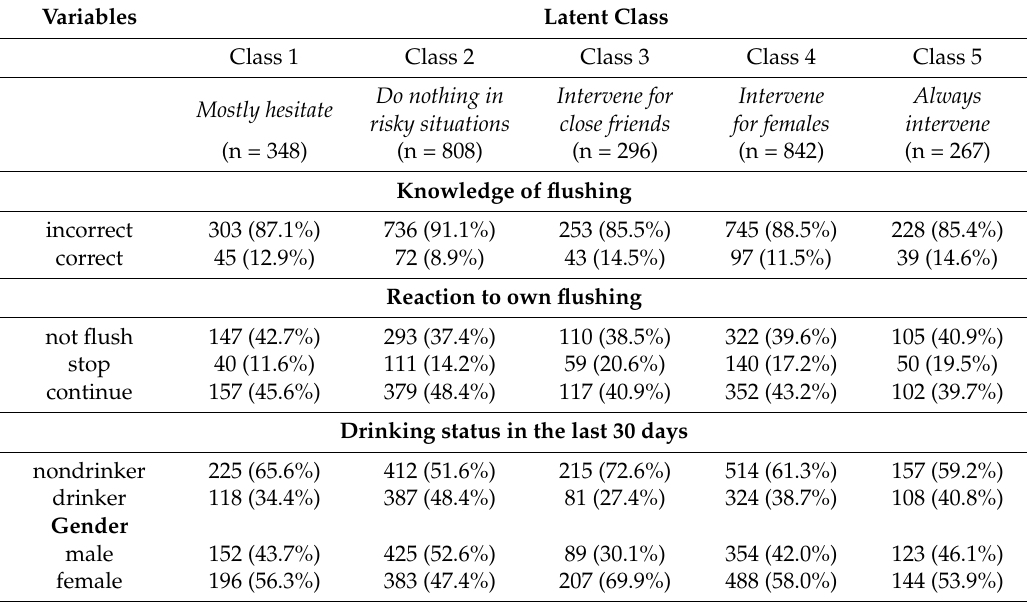
Table 2. Frequency and percentage distribution of class membership by knowledge, gender, drinking status, and reaction to own flushing (numbers in parentheses are the percentage).